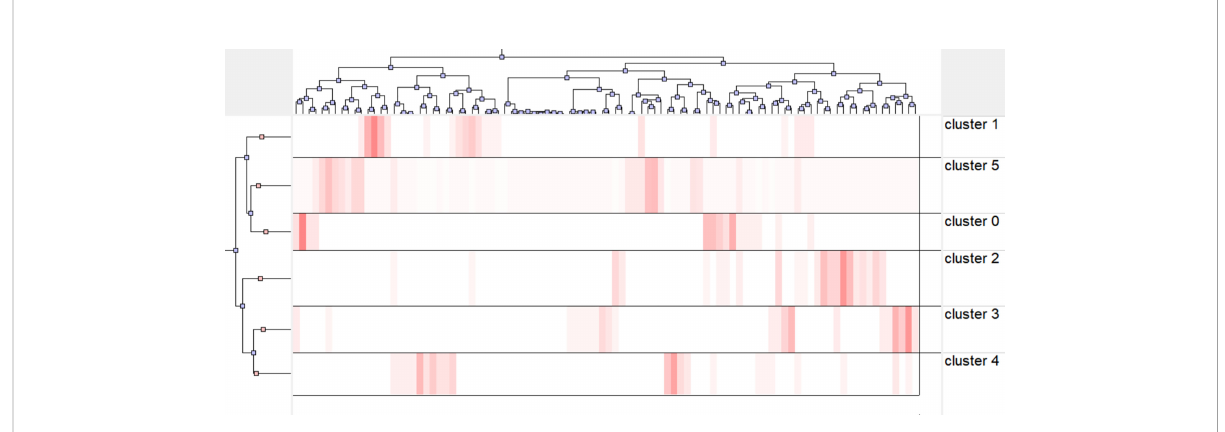
FIGURE 10 The visualized heat map linked to data